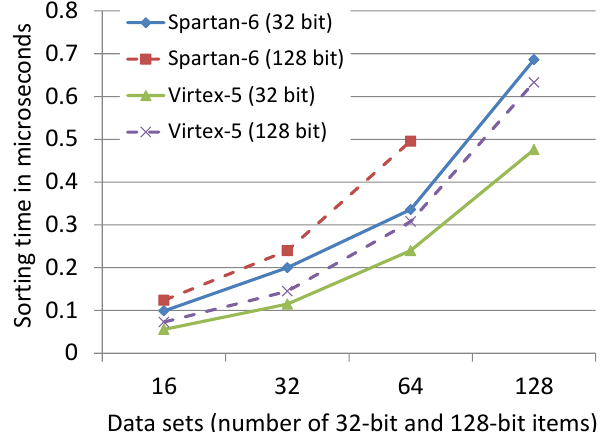
Fig. 12. The results of sorting similar to Fig. 10 but for 32- and 128-bit data